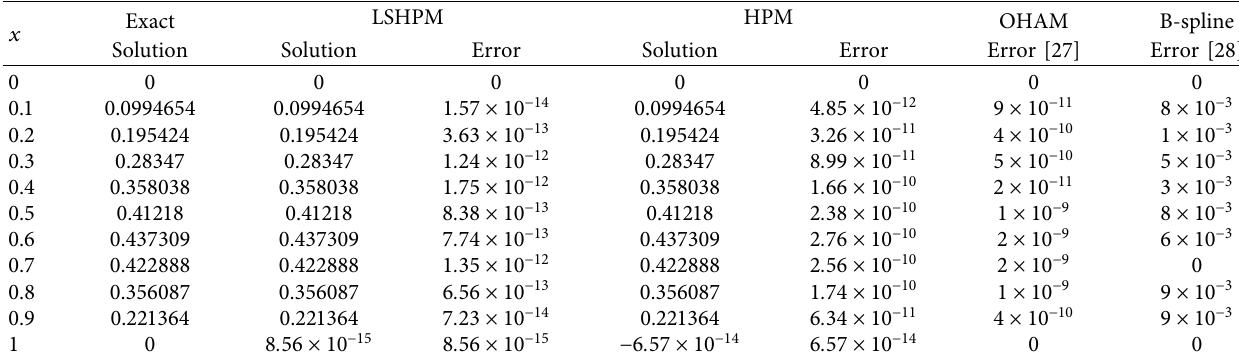
Table 7: Comparison of second-order absolute error of LSHPM with HPM, OHAM, and B-spline in Problem 7.